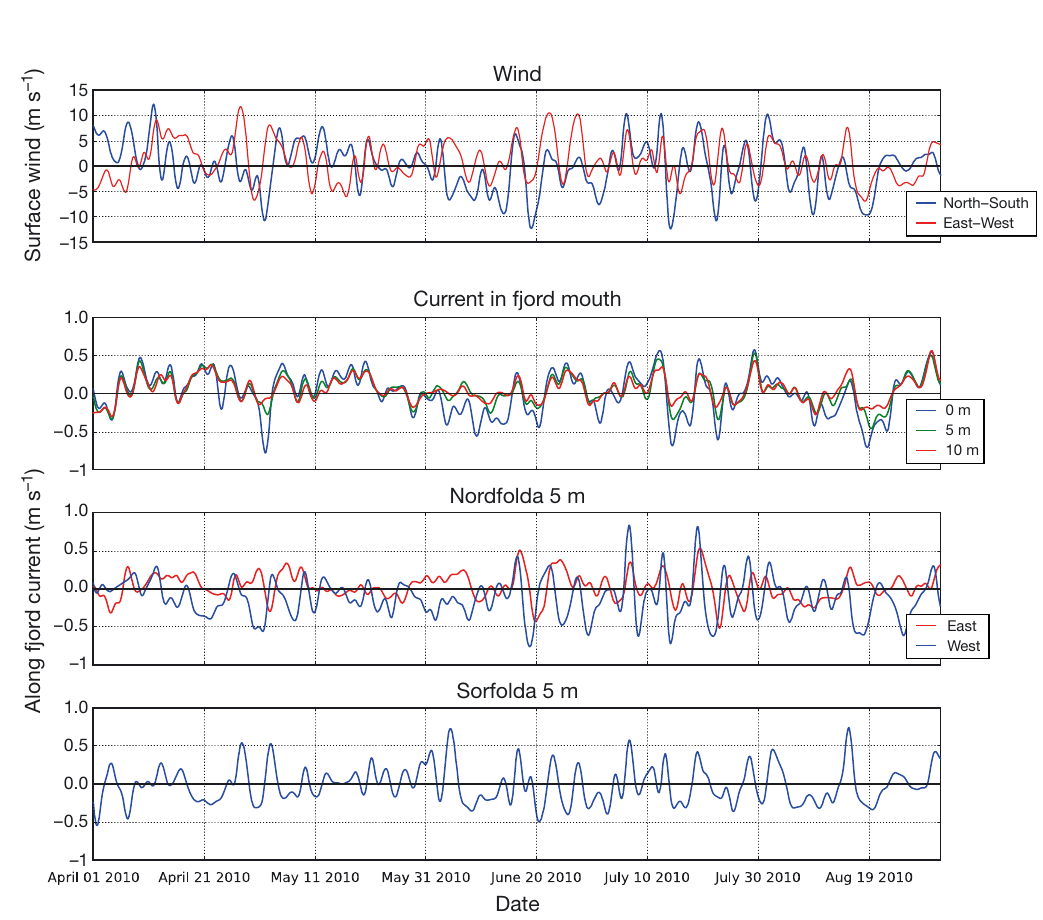
Fig. 3. Simulated surface wind at Vestfjorden outside the Folda fjord system and along fjord current in the middle of the mouth of Folda (0, 5 and 10 m depth, compass direction 60°), Nordfolda (east and west side, 5 m, compass direction 45°) and Sørfolda (5 m, compass direction 135°). Positive currents are directed into the